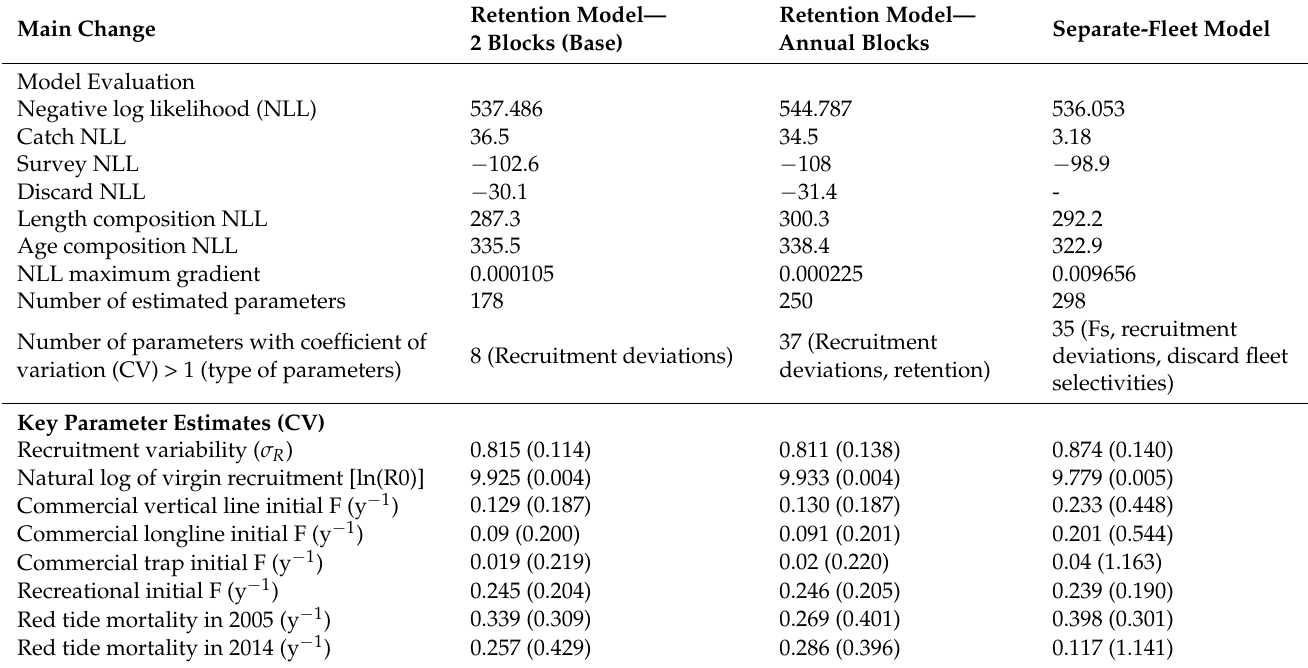
Table 2. Comparison of model results for the Gulf red grouper case study exploring different approaches to modeling discards. Note that negative log likelihoods are not comparable for the separate-fleet model due to changes in input